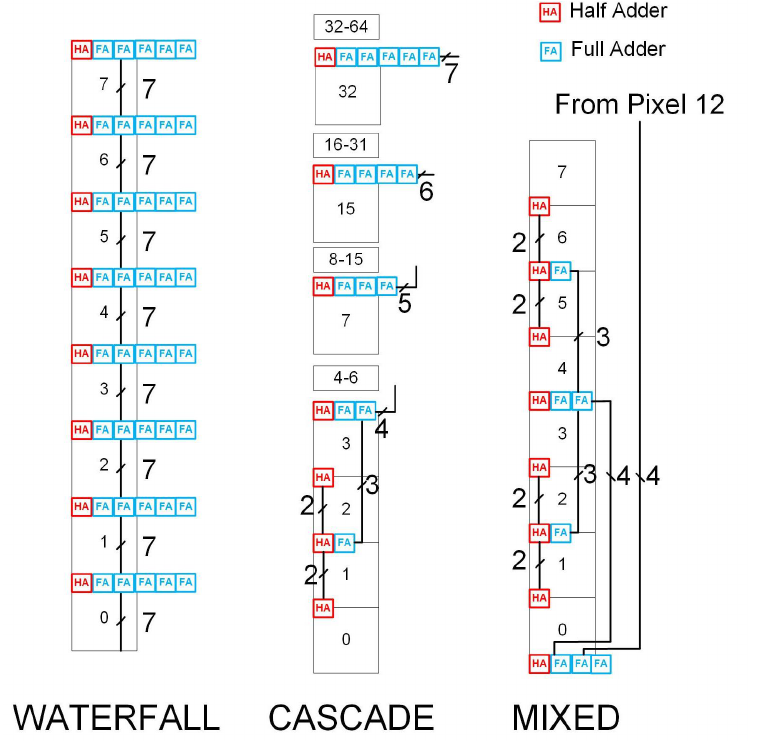
Figure 9. Diagram illustrating the possible options for summing a column of pixels. Numbers in boxes represent pixel numbers, other numbers show bus